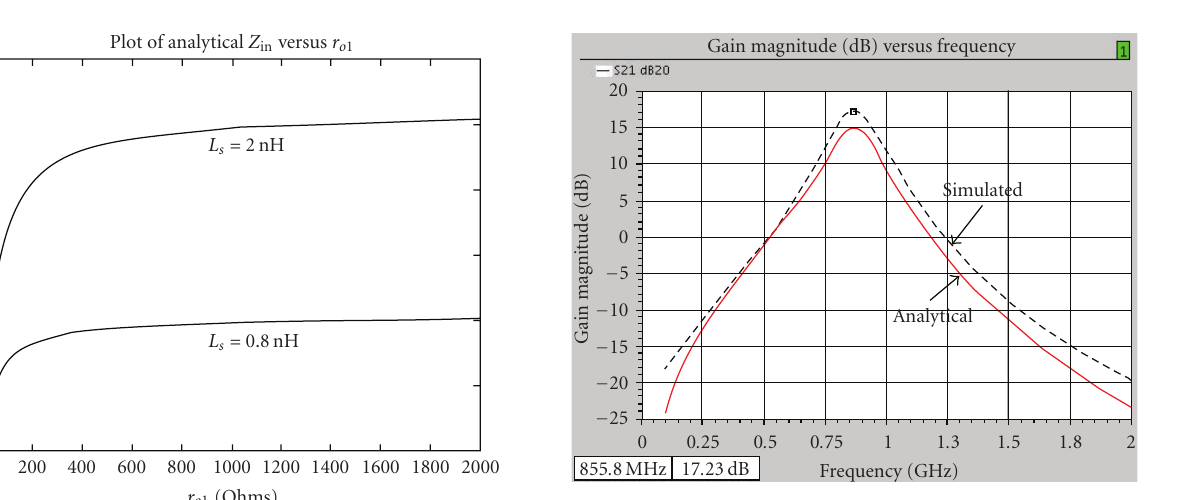
Figure 3: Analytical and simulated gain-magnitude ( A V in dB) of the RFID